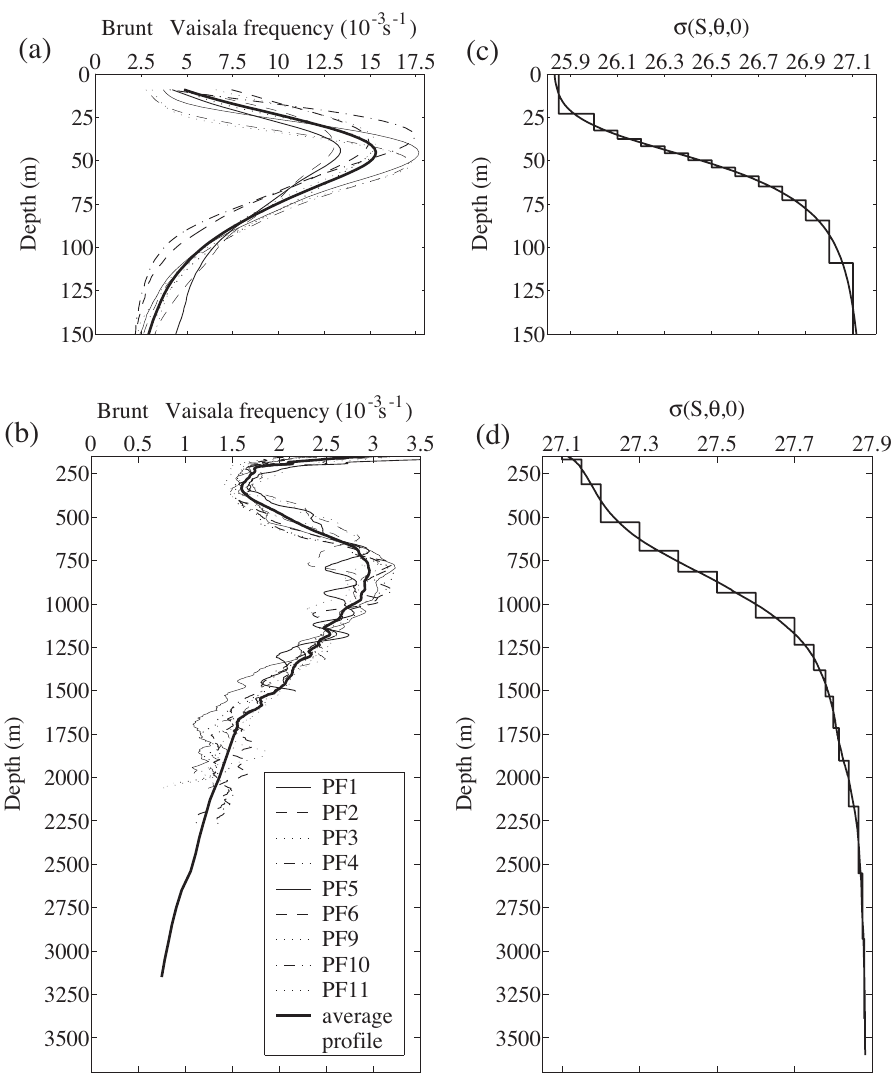
F IG . 3. – Initial density profile in September. (a-b) Brünt-Vaïsala frequency, N, from 0 to 150 m depth (a) and from 150 to 3500 m depth (b). The solid bold line is the mean Brünt-Vaïsala profile and the others are the tidal-cycle-averaged N profiles from stations. Inside the